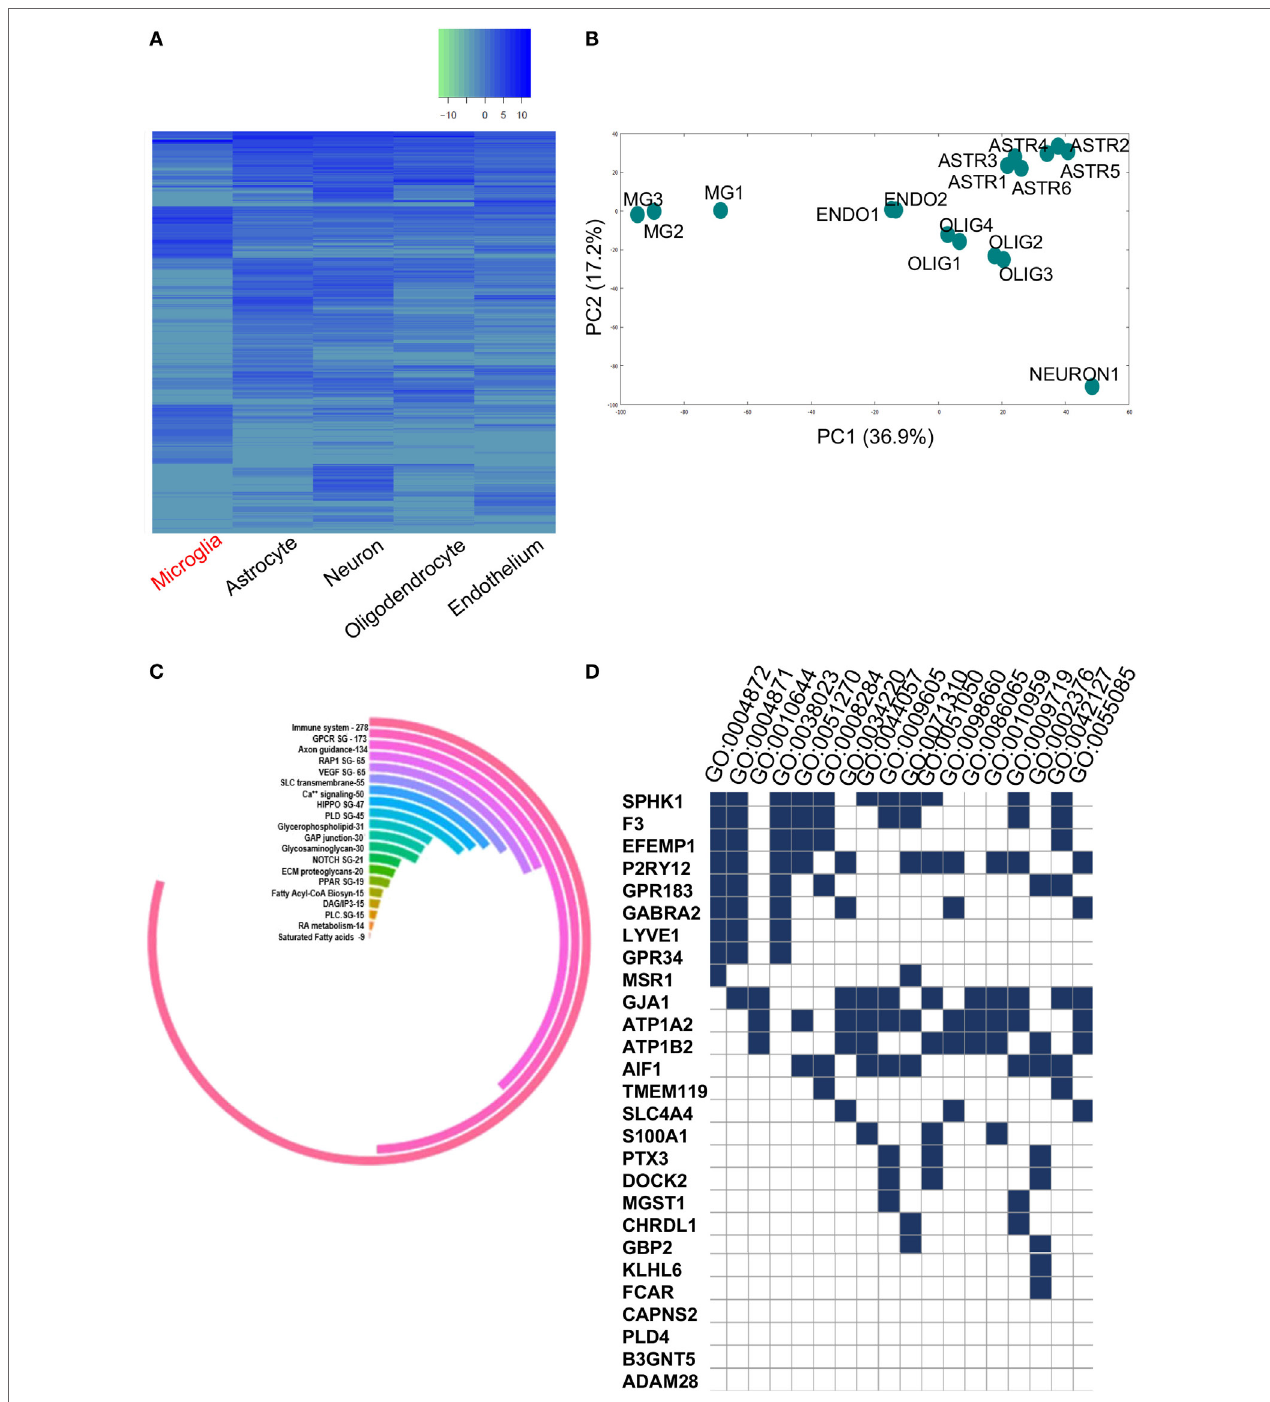
FigUre 2 | (a) Heatmap representing significantly expressed upregulated and downregulated gene profiles of various brain cell types. (B) Principal component analysis plot showing homogeneity within each cell type and diversity among the five brain cell types namely, microglia, endothelial cells, oligodendrocytes, neurons, and astrocytes. (c) Circular plot showing pathway analysis of total dysregulated gene list (3,290) between ROBC and microglia. (D) GSE Analysis showing enriched GO BP/MF terms ( p < 0.05) in 27 shortlisted genes overlapping between primary and secondary